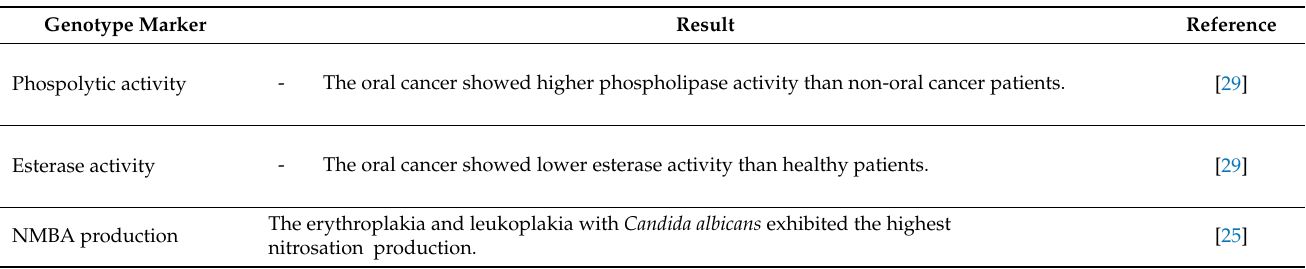
Table 5. The Candida albicans metabolic product identified in each